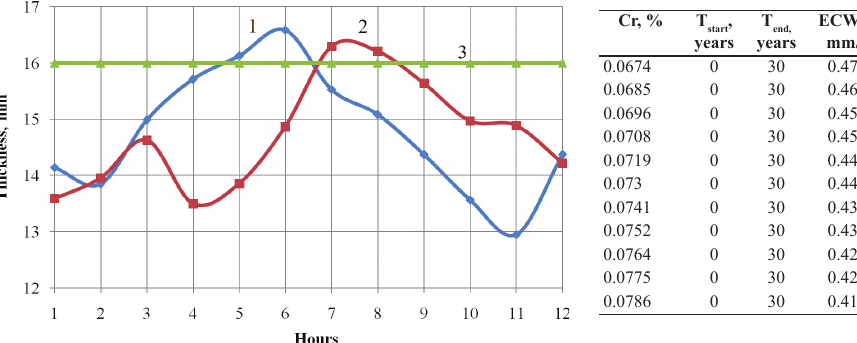
Figure 1. Minimum bend wall thicknesses (Baranenko et al.